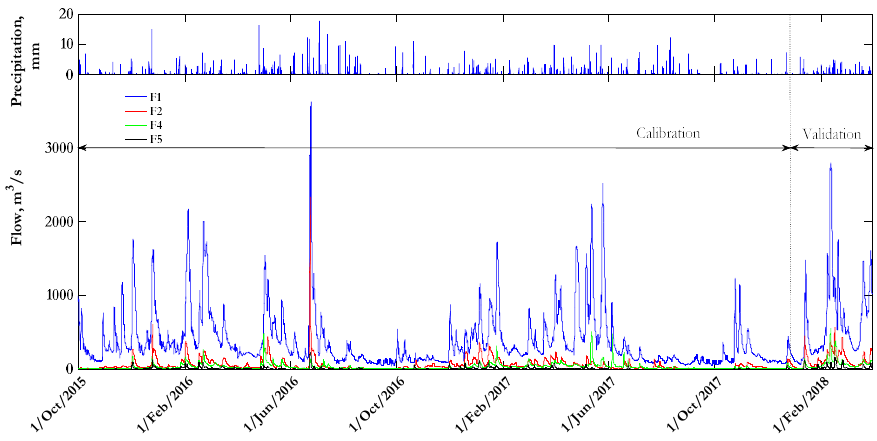
Figure 4. Observed precipitation and flows in the Kanawha River and its tributaries during 1 October 2015 to 31 March 2018.